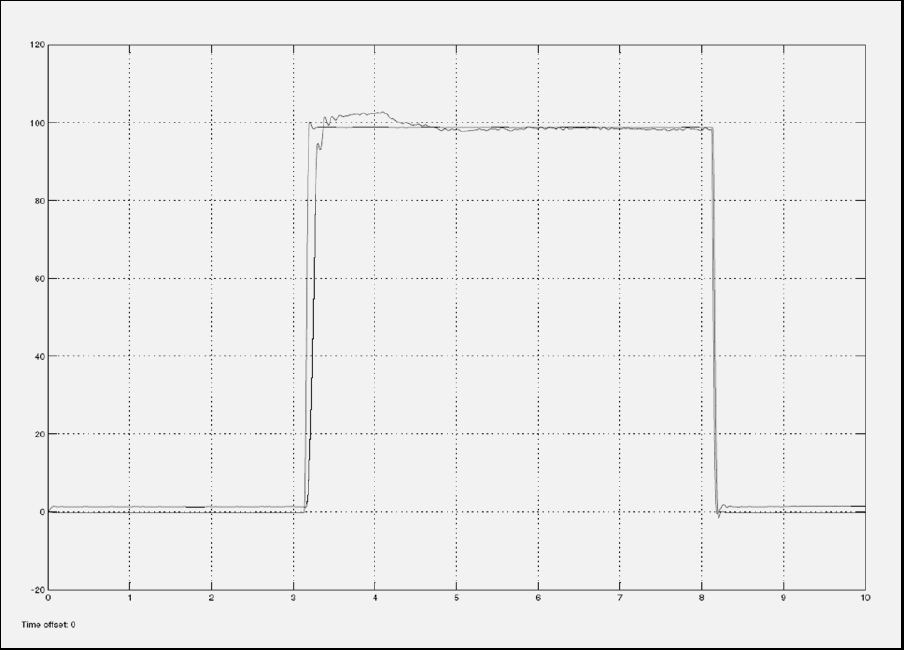
Figure 8. Return EFC Valve with 1.6 Amps current